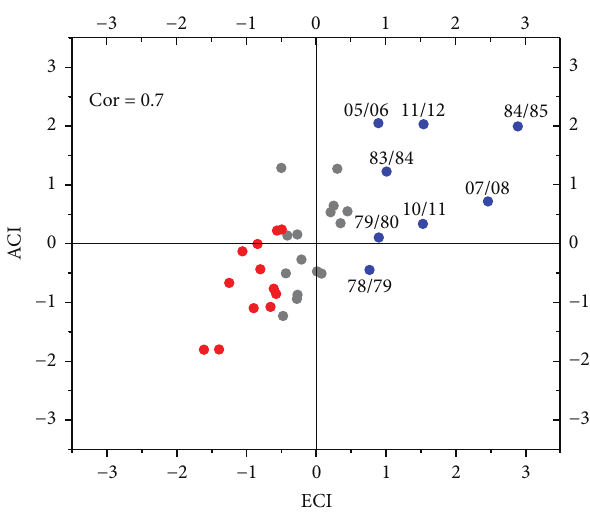
Figure 7: Scatter plot of the ECI and ACI for reanalysis. The blue and red marks indicate high and low ECI years ( ± 0.5 SD), respec- tively; the grey marks indicate the ECI that were neither high nor low